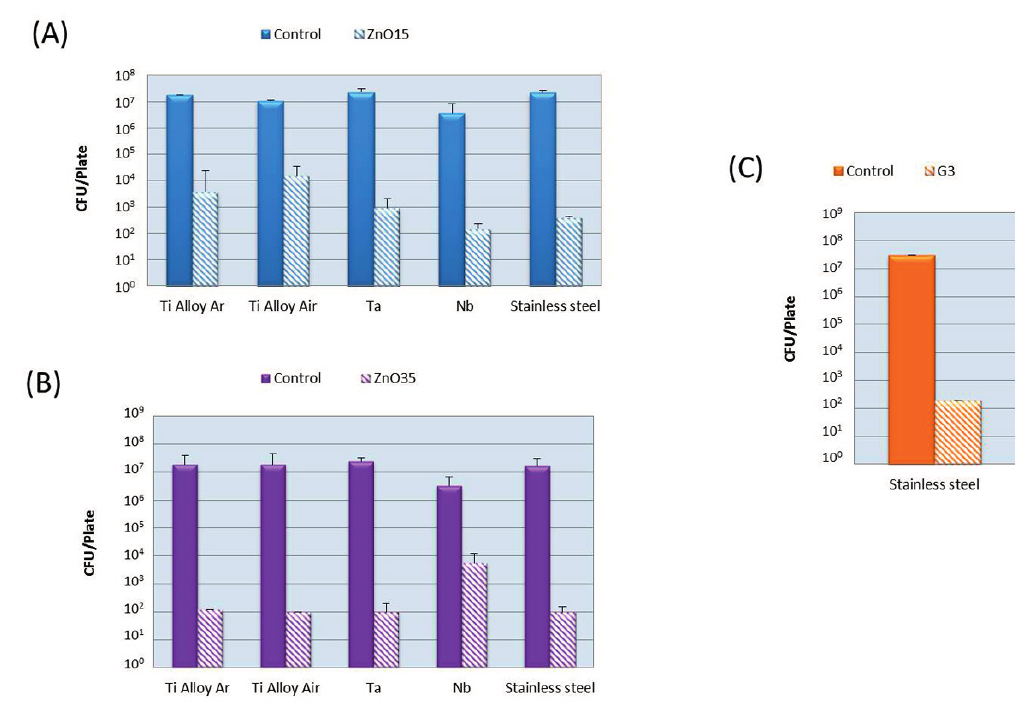
Figure 8. Antibacterial activity against E. coli of the coatings with: ( A ) ZnO15; ( B ) ZnO35 and ( C ) G3. Bars represent media (SD) from three